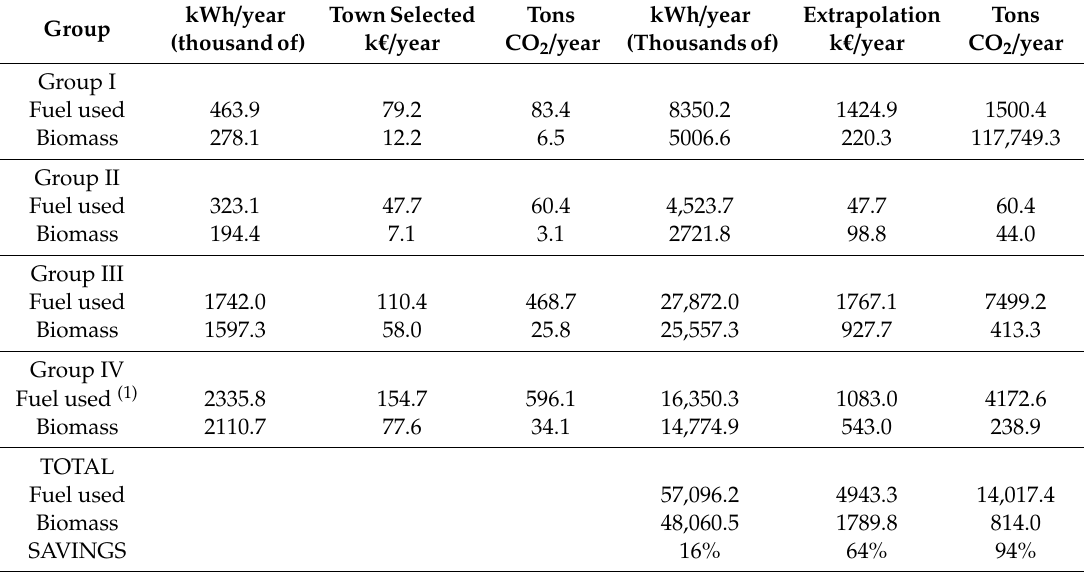
Table A12. Extrapolation to the Pontevedra province (optimum